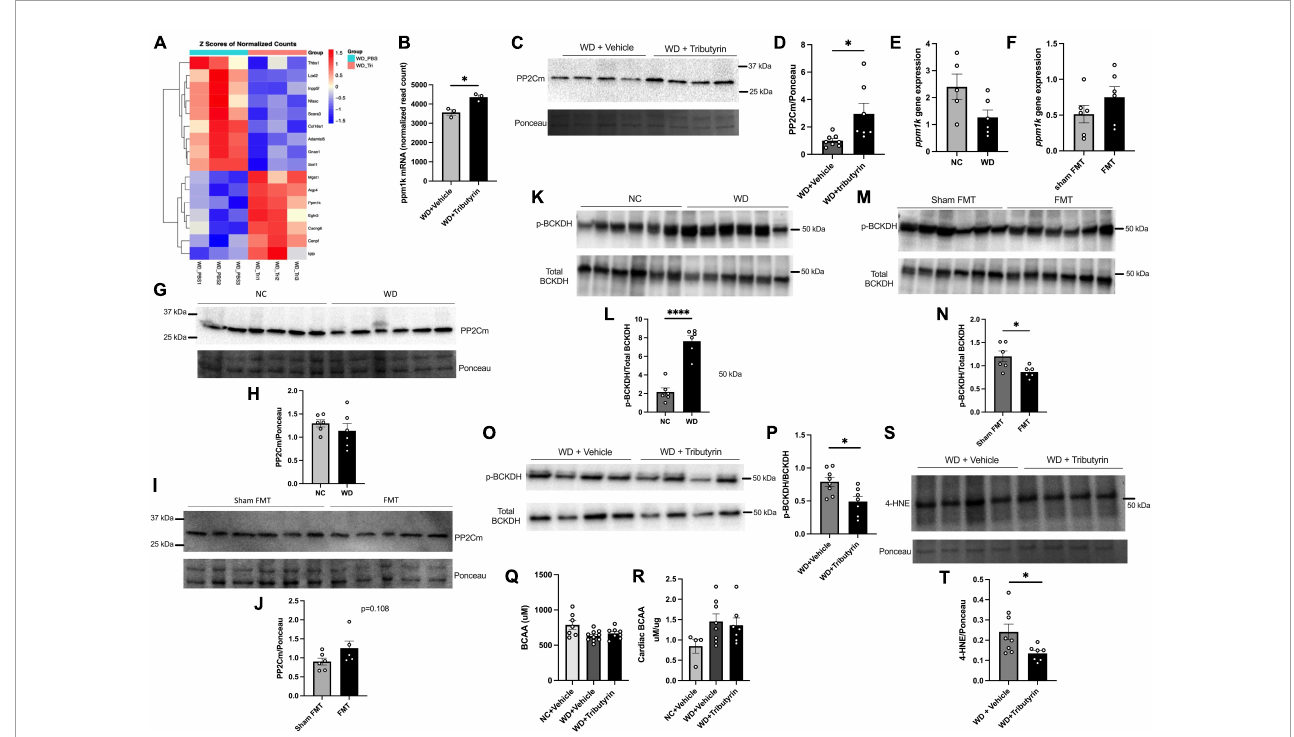
FIGURE4 Tributyrin alters transcripts in the heart. (A) Topmost regulated transcripts after Tributyrin treatment in the heart (WD, WD + Tributyrin needle fed mice), FDR-adjusted P < 0.1 (n = 3 per group) ( Supplementary Datasheet 2 ). (B) ppm1k mRNA normalized read count in WD and WD + Tributyrin treated mice (FDR-adjusted P = 0.049515631) (C) Immunoblot images of PP2Cm and total ponceau staining from hearts of WD fed mice treated with Tributyrin or vehicle. (D) Densitometric analysis of the ratio of PP2Cm to total protein staining bands, ( n = 7–8 per group). (E) mRNA levels of ppm1k in heart from NC and WD fed mice ( n = 5–6 per group). (F) mRNA levels of ppm1k in heart from sham FMT and lean FMT treated mice ( n = 6 per group). (G) Immunoblot images of PP2Cm and total protein staining from NC and WD fed mice. (H) Densitometric analysis of the ratio of PP2Cm to total protein staining bands ( n = 6 per group). (I) Immunoblot images of PP2Cm and total protein staining from sham FMT and FMT treated mice. (J) Densitometric analysis of the ratio of PP2Cm to total protein staining bands ( n = 5–6 per group). (K) Immunoblot images of p-BCKDH, total BCKDH and total protein staining from hearts of NC and WD fed mice. (L) Densitometric analysis of the ratio of p-BCKDH/BCKDH protein bands ( n = 6 per group). (M) Immunoblot images of p-BCKDH, total BCKDH and total protein staining from hearts of WD fed mice treated with sham FMT or FMT. (N) Densitometric analysis of the ratio of p-BCKDH/BCKDH protein bands ( n = 6 per group). (O) Immunoblot images of p-BCKDH, total BCKDH and total protein staining from hearts of WD fed mice treated with Tributyrin or vehicle. (P) Densitometric analysis of the ratio of p-BCKDH/BCKDH protein bands ( n = 7–8 per group). (Q) Serum BCAA levels in NC, WD and WD + Tributyrin treated mice ( n = 8–10). (R) Cardiac BCAA levels in NC, WD and WD + Tributyrin treated mice normalized to total protein levels (n = 4–8). (S) Immunoblot images of 4-HNE and total protein staining from hearts of WD fed mice treated with Tributyrin or vehicle, (T) Densitometric analysis of the ratio of 4-HNE to total protein staining protein bands. Statistical analysis was done using unpaired student’s t -test. Data are mean ± S.E.M. ( ∗ p < 0.05), ( n = 7–8 per group). Statistical analysis was done using unpaired student’s t -test and one-way ANOVA followed by Tukey’s multiple comparison test. Data are mean ± S.E.M. ( ∗ p < 0.05, ∗∗∗∗ p <